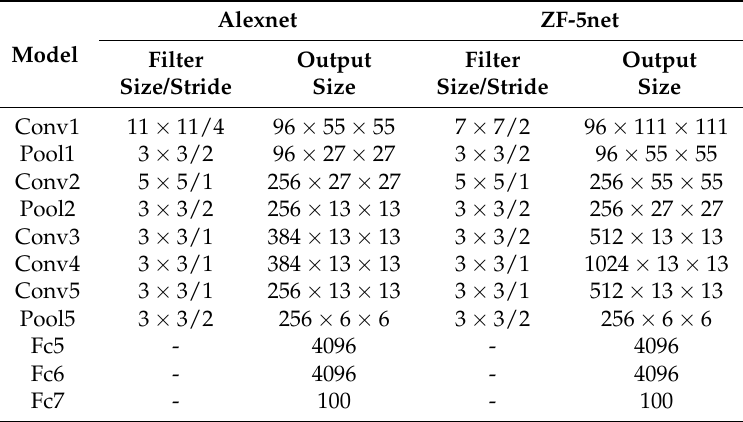
Table 2. The configurations of the Alexnet and